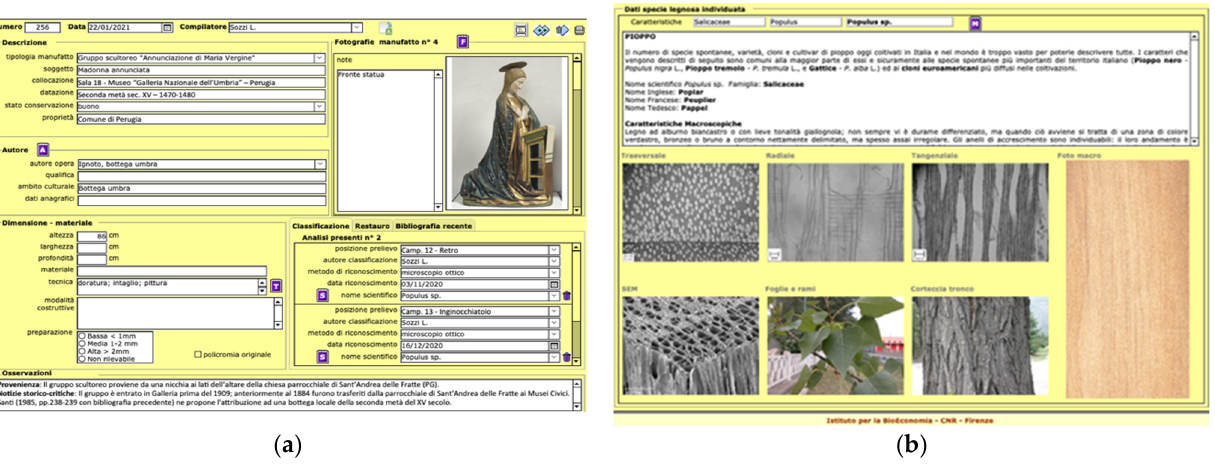
Figure 1. Two entries related to each other in ArISStArt, the one relating to the artwork ( a ) and the one describing the wood of the carving ( b ) (texts in Italian).